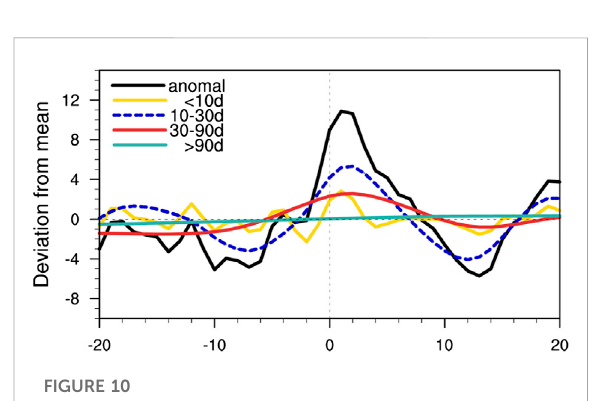
FIGURE 10 Same as Figure 5, but for the low-latitude key region.